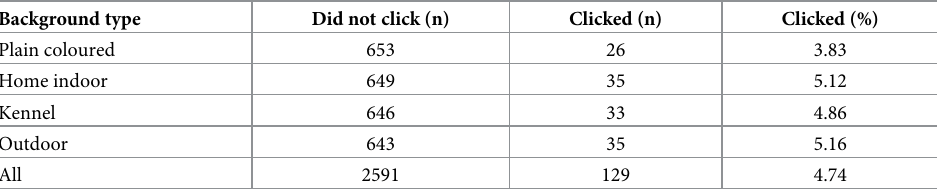
Table 3. The number (n) and percentage (%) of link clicking responses between background types. Background